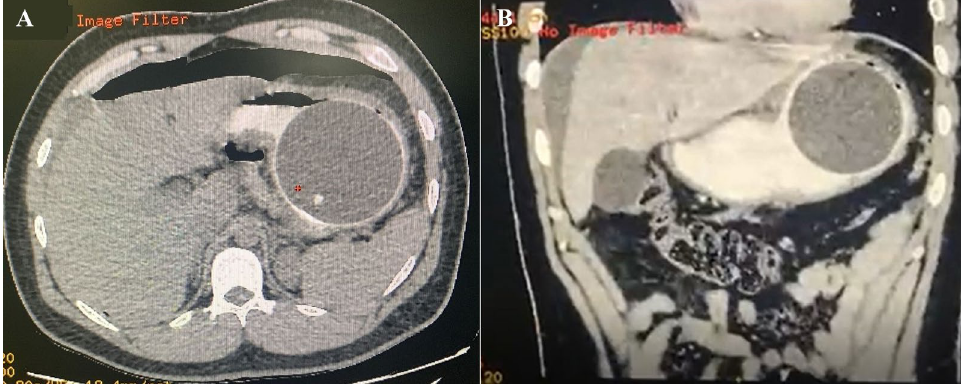
Fig. 1 A CT, Free air in the abdomen. B CT, Perihepatic liquid along with the intragastric balloon